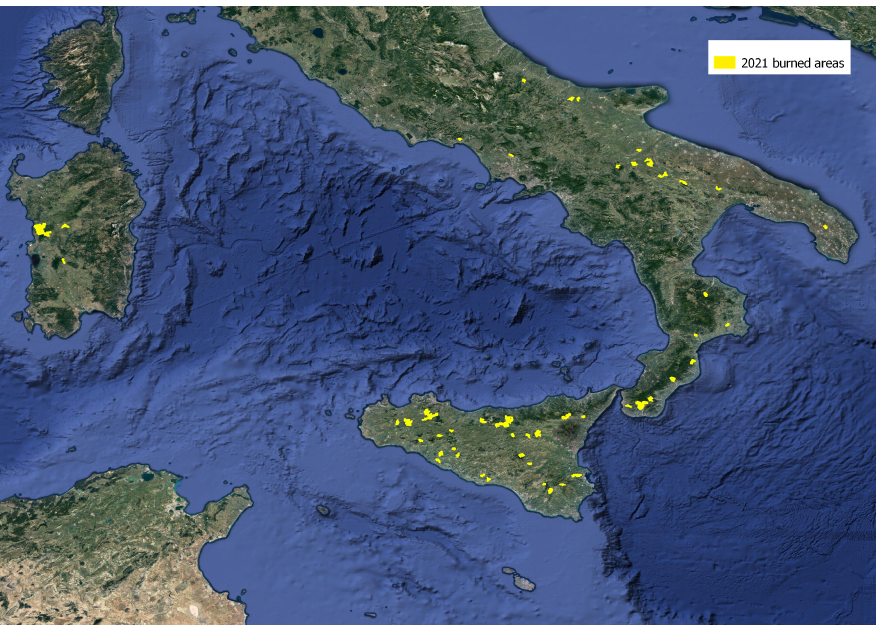
Figure 6. In this figure, the remote-sensing retrieved burned areas corresponding to 55 wild- fires greater than 500 hectares considered during the validation of the Summer susceptibility map are